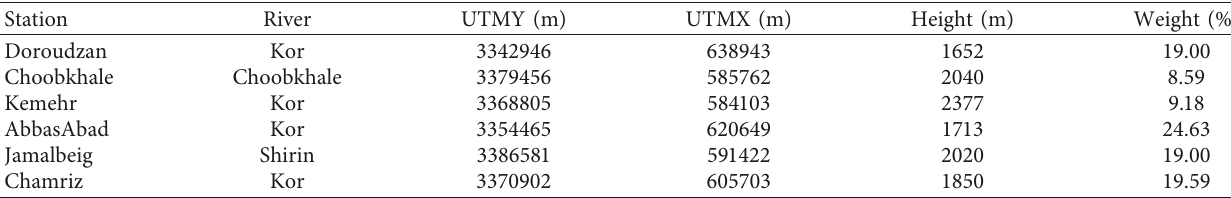
Figure 1: Position of the stations under study. Table 2: Features of the stations under study.